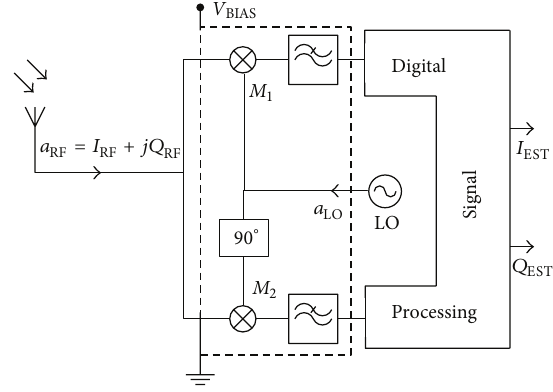
Figure 2: Block diagram of a low-IF receiver using 𝐼 - 𝑄 demodula-